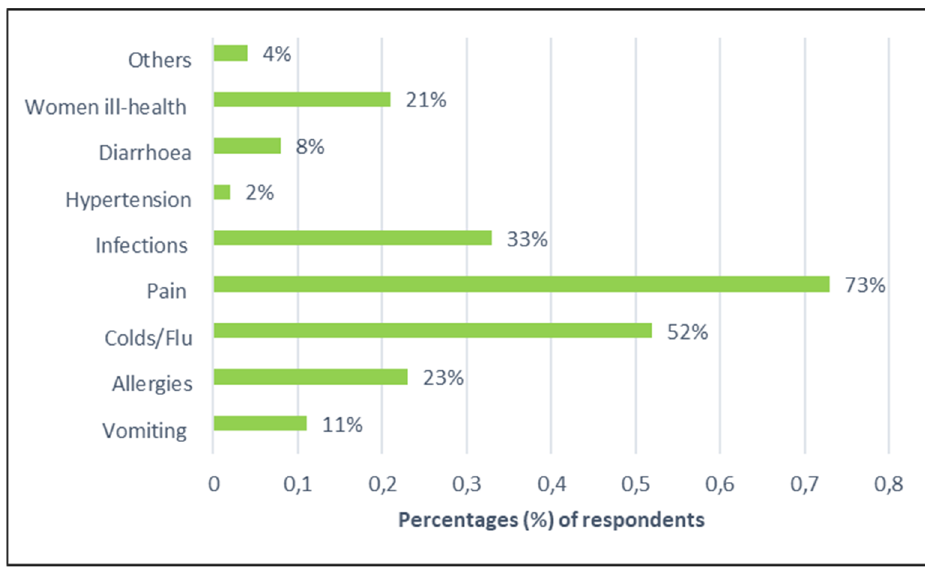
Figure 2. Proportions of respondents according to medicines used in their homes.